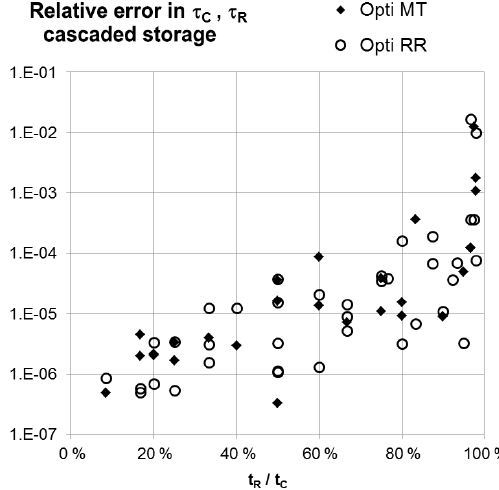
Figure 7. Relative error ε(τ X )/τ X of the time constants τ C and τ R for the cascaded storage approach with respect to optimizations ver- sus total mass M T or versus river runoff R R